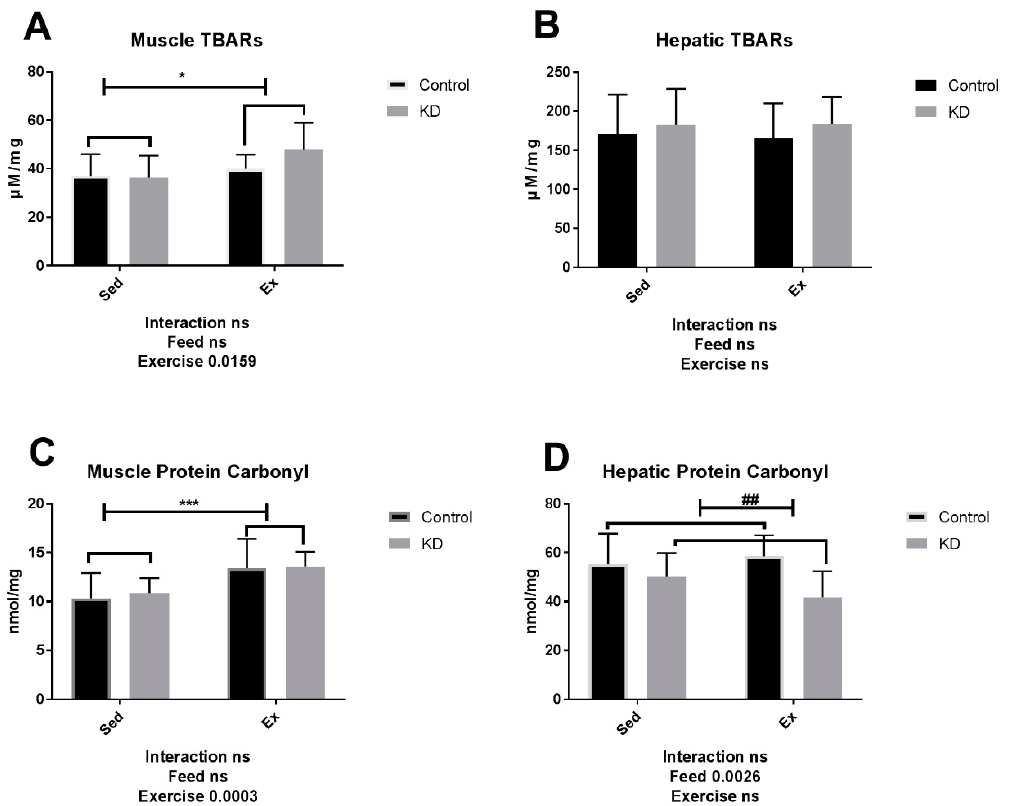
Figure 6. Muscle and hepatic oxidative stress immediately after exhaustion. ( A,B ) TBARs in plantaris muscle tissue and liver tissue. ( C,D ) Protein carbonyl in plantaris muscle tissue and liver tissue. * p < 0.05, *** p < 0.001 compared between sedentary and exercise, ## p < 0.01 compared between control diet and KD.